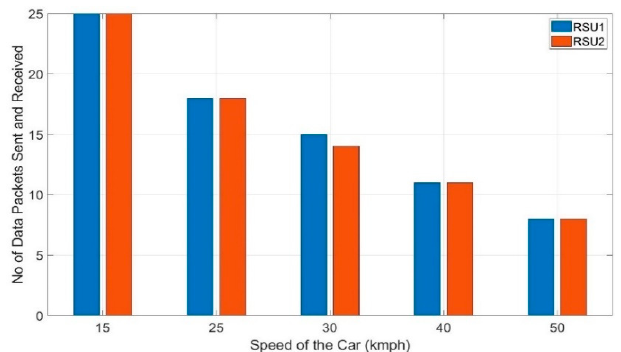
Figure 11. The number of data packets received by each RSU in preliminary testing with Kalman filter.